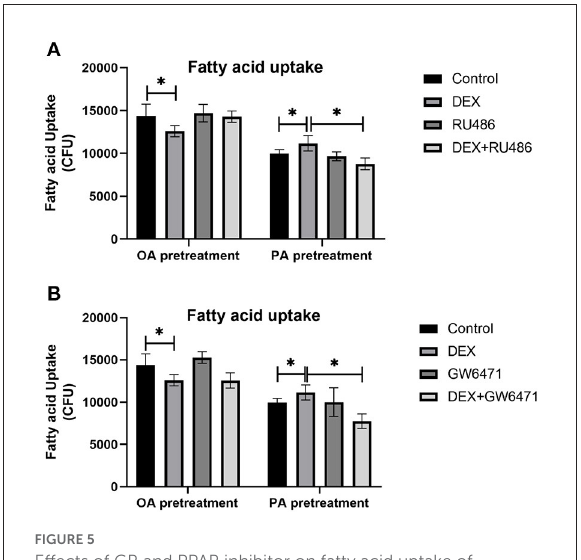
FIGURE5 Effects of GR and PPAR inhibitor on fatty acid uptake of myoblasts. (A) Effects of GR inhibitor on fatty acid uptake in myoblasts; (B) Effects of PPAR inhibitor on fatty acid uptake in myoblasts. Data are presented as the mean ± SEM ( n = 6). * P <